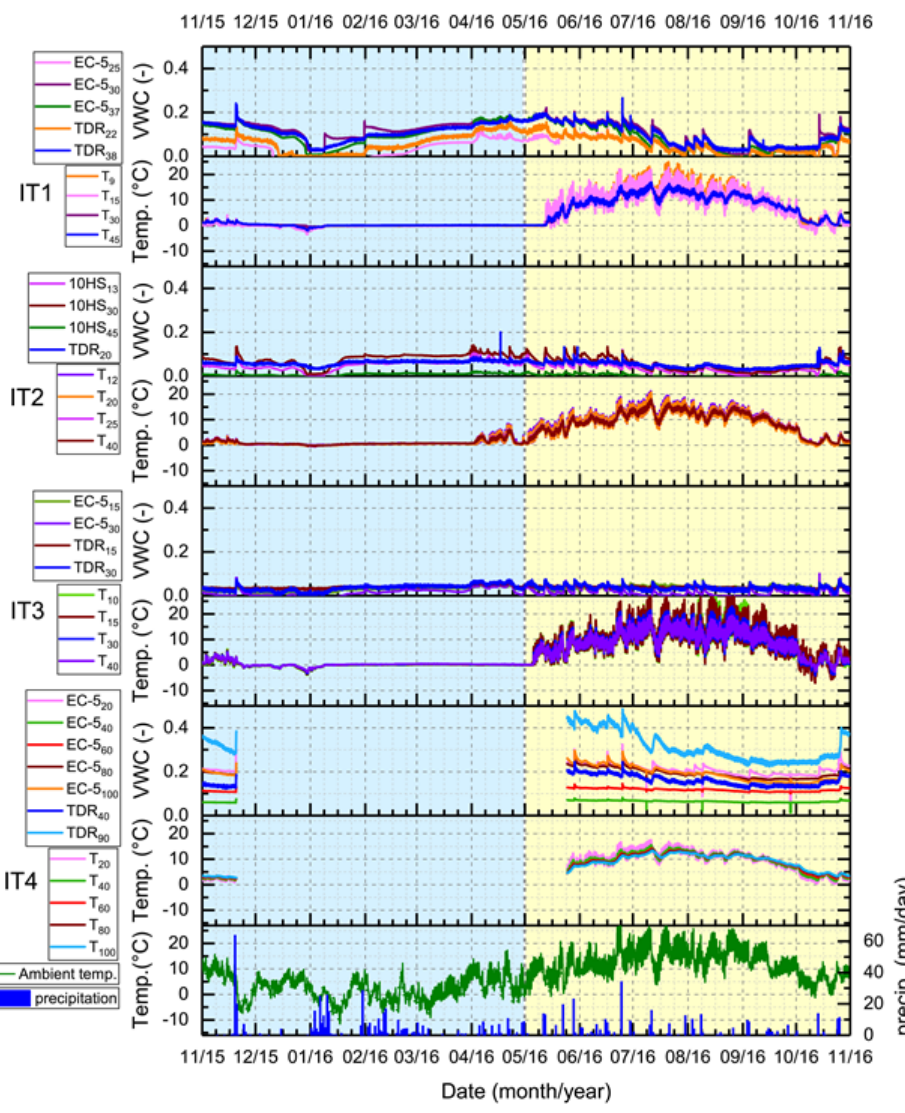
Figure 12. Measurements at instrumented trenches IT1-4 during the last year of seasonal field monitoring (November 2015–October 2016): VWC, temperature with precipitation and ambient air data on the bottom.